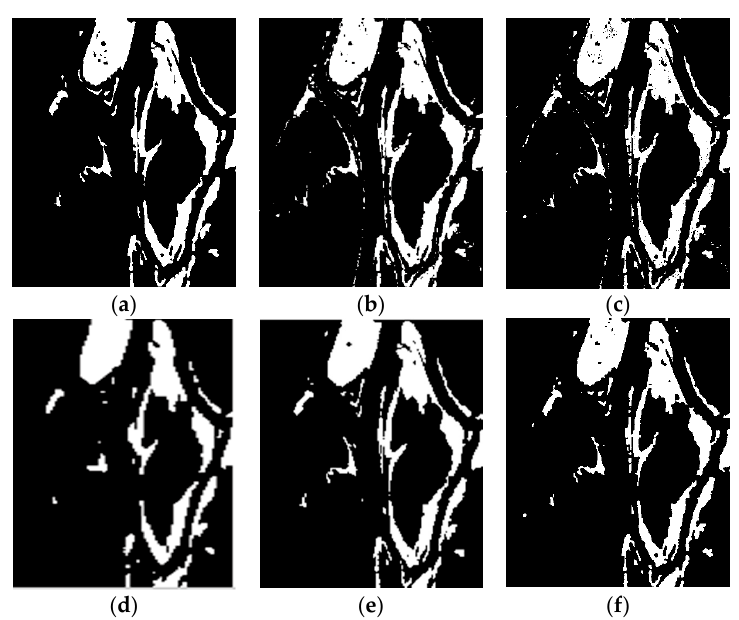
Figure 6. Change detection images obtained for the Ottawa data set: ( a ) The reference change image; ( b ) NSCT-FCM; ( c ) MRF-FCM; ( d ) PA-GT; ( e ) PCA-NLM; ( f ) Proposed algorithm.